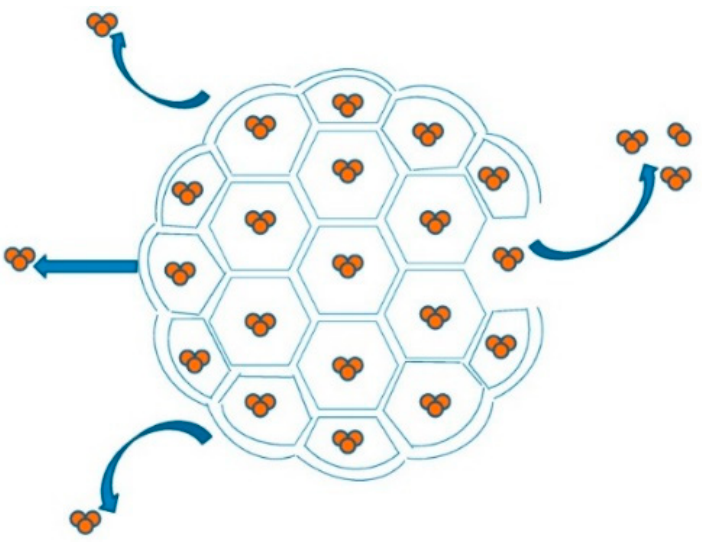
Figure 5. Spheroid and granular structure of a DepoFoam ™ particle. Reproduced with permission Figure 5 . Spheroid and granular structure of a DepoFoam™ particle. Reproduced with permission from [26] (published by MDPI), licened under CC from [26] (published by MDPI), licened under CC BY.